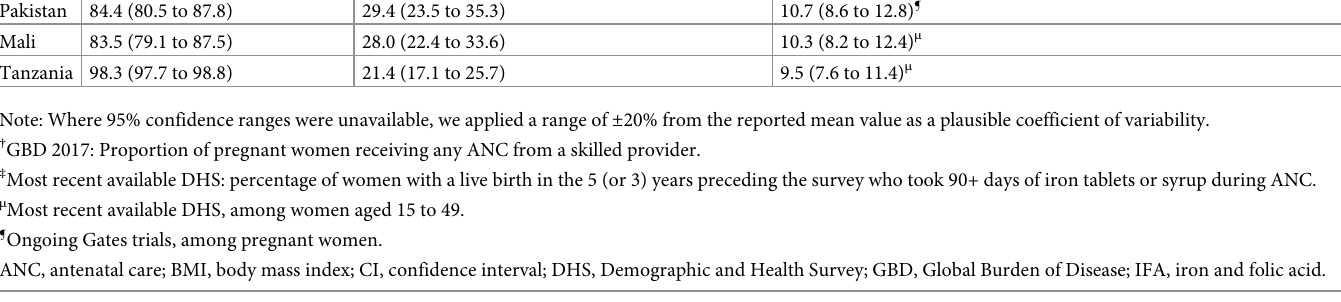
Women who are undernourished according to BMI ( < 18.5 kg/m 2 ) (%)